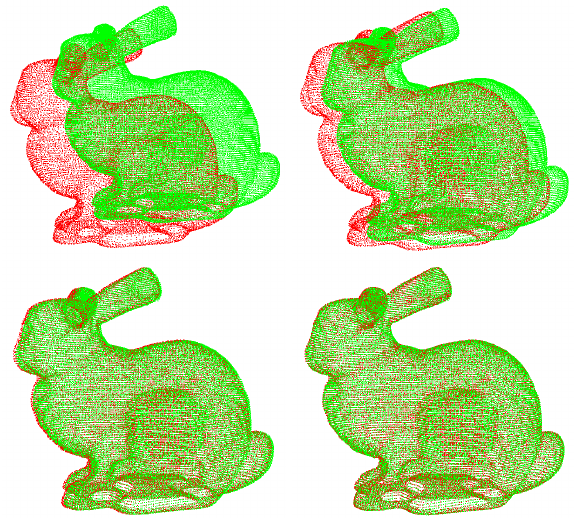
Figure 4: ICP process applied to the Stanford bunny point cloud with coarse subject (red) and dense reference (green) In contrast to the bunny datasets, the two Welfenschloss datasets present a different origin, and thus a different point of view.